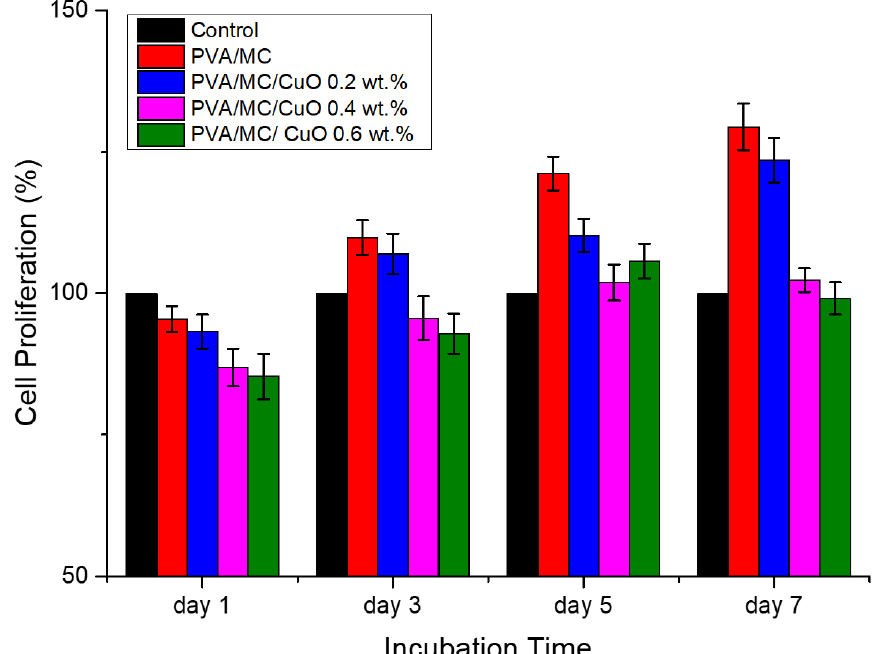
Figure 9. The cell viability of samples after one, three, five and seven days